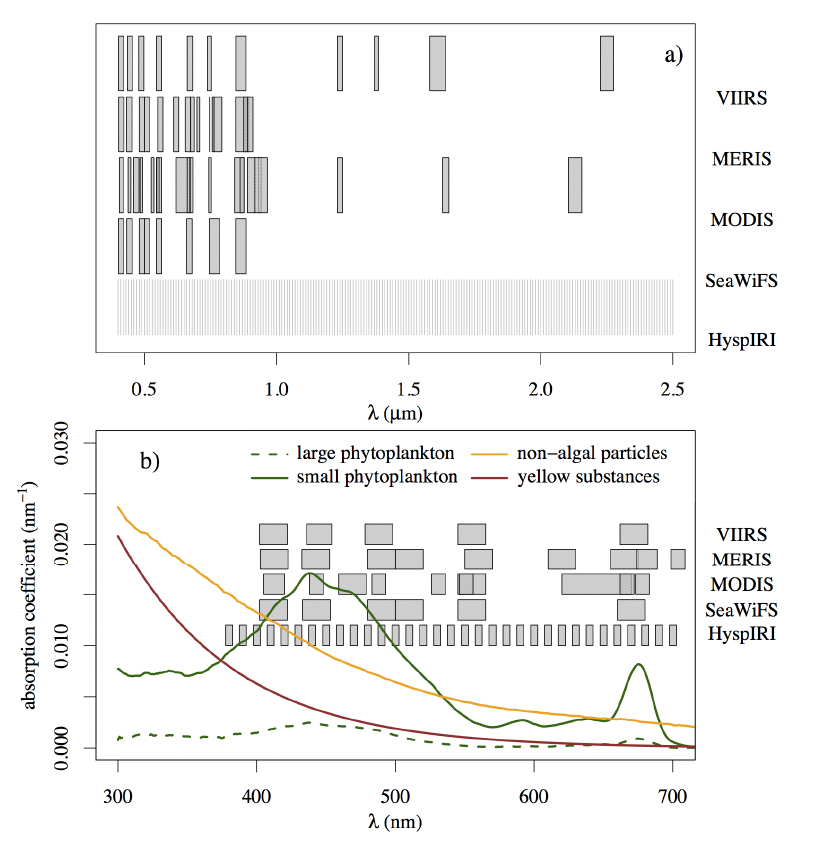
Figure 1. (a ) Spectral coverage of HyspIRI and standard ocean color sensors in the VSWIR region; ( b ) Absorption coefficients of phytoplankton (small and large cells), non-algal particles, and yellow substances, and the spectral coverage of the aforementioned sensors in the visible region. All bands are shown for MODIS and MERIS (MEdium Resolution Imaging Spectrometer), some of which overlap. However, only the moderate resolution bands are shown for VIIRS (Visible Infrared Imaging